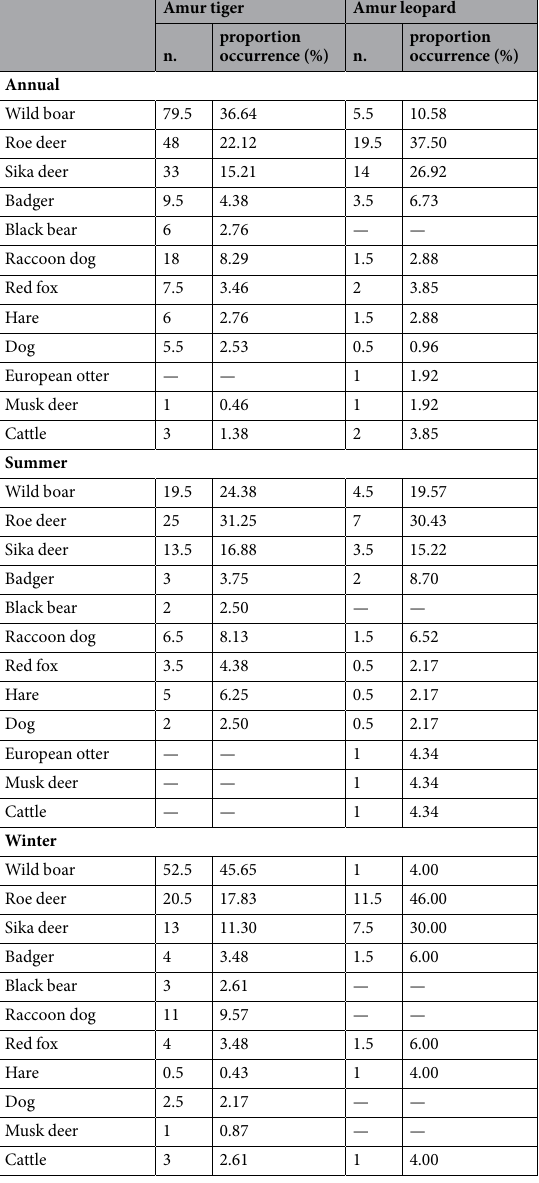
Table 2. Number of prey items and proportion (%) of different prey species in the annual and seasonal diets of Amur tiger and Amur leopard in NE